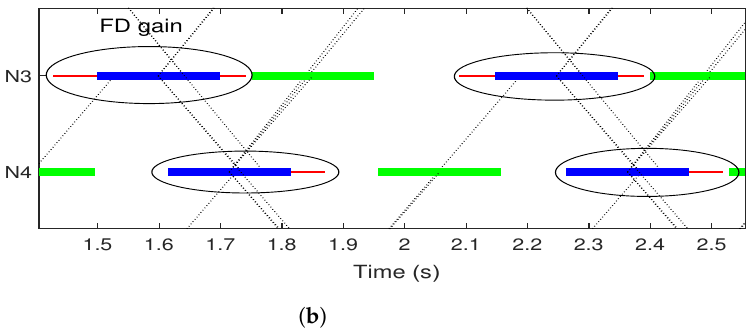
Figure 8. Zoomed in sections of Figure 7a,b. ( a ) LTDA-MAC. ( b ) FD-LTDA-MAC.